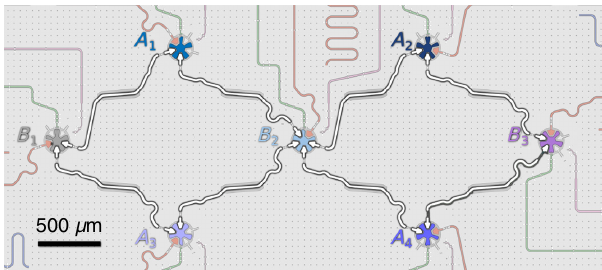
FIG. 7. Optical micrograph of the device. Each qubit (colors corresponding to the colors in Fig. 2) is connected to neighboring qubits by coupling resonators (white). Each qubit is connected to a readout resonator (red), a flux line (green), and a drive line